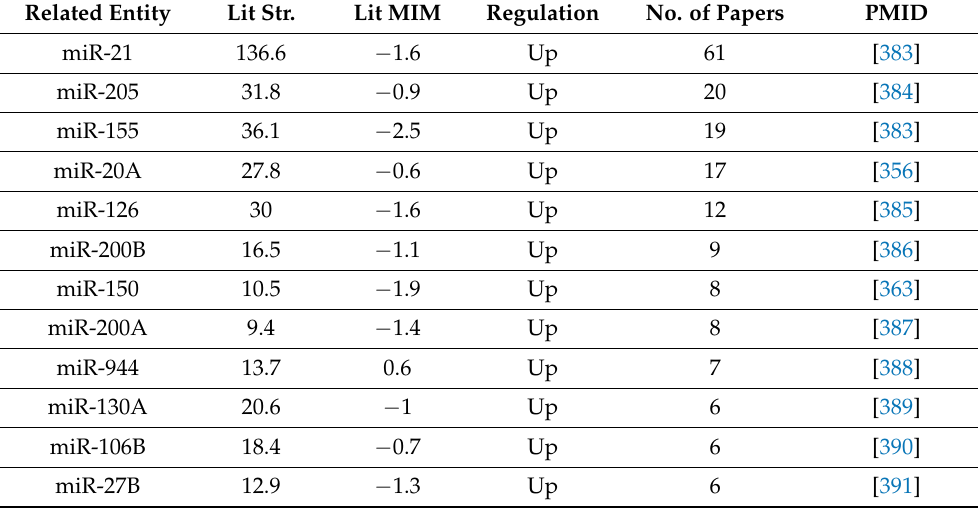
Table 5. Deregulated miR in Cervical